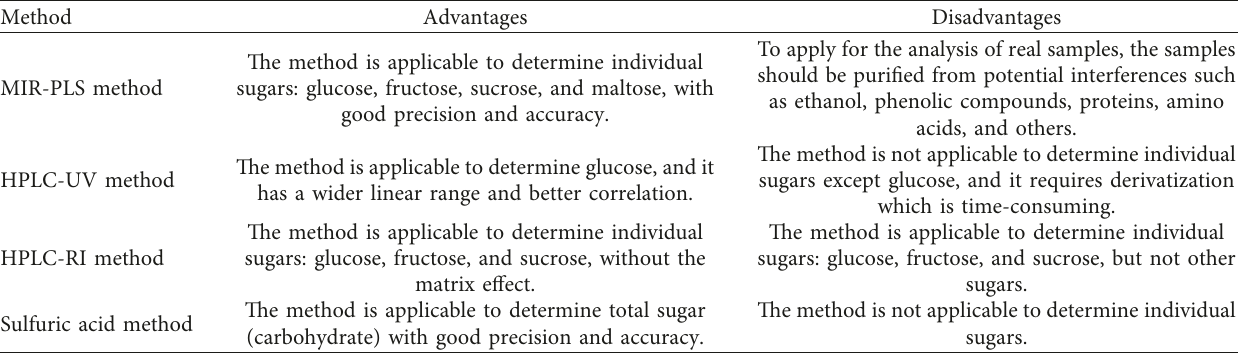
Table 5: Comparison of advantages and disadvantages of the four newly developed methods for the determination of sugars in the fermented alcoholic beverages.